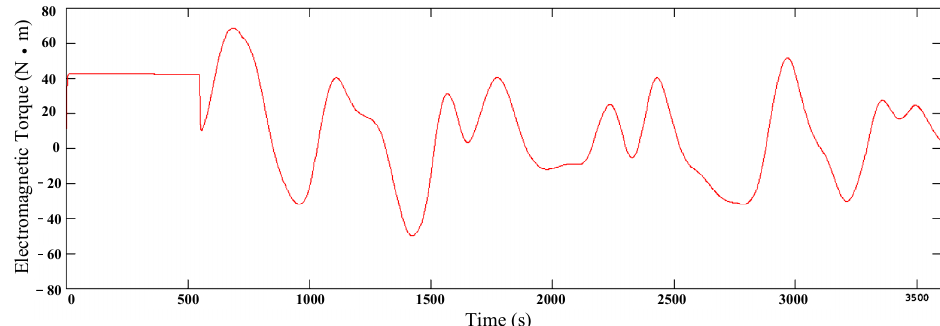
Figure 11. The electromagnetic torque waveform of the PMSM.